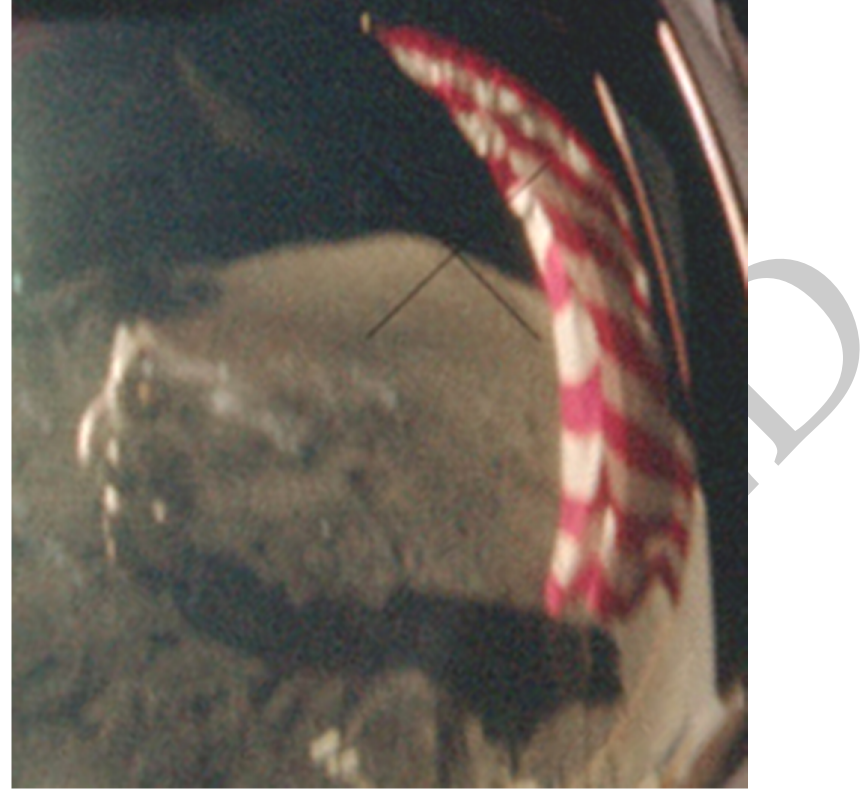
Figure 16. Reflection of the helmet (zoomed from photo AS17-134-20384).